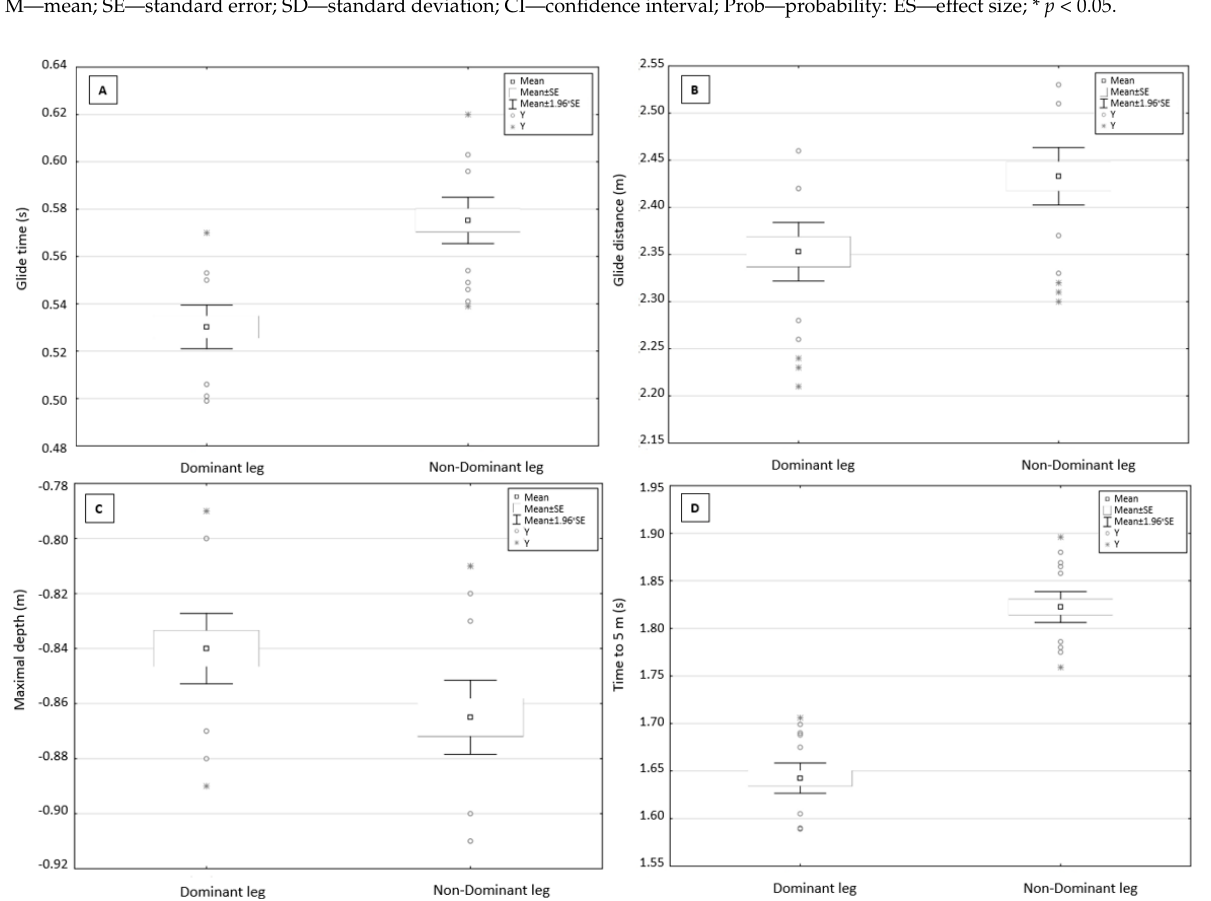
Figure 3. Dominant and non-dominant leg placed on the front edge—( A )—glide time; ( B )—glide distance; ( C )—maximal depth; ( D )—time to 5